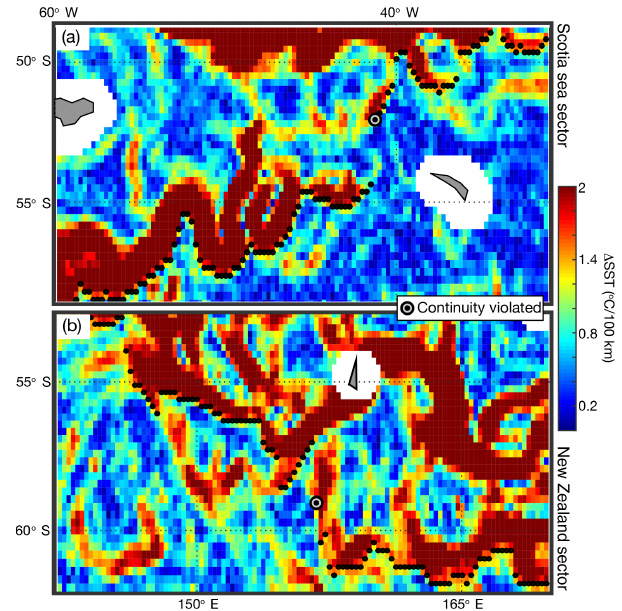
Figure 2. Example cases when spatial and thermal discontinuity is justified: frontal filaments (a) disconnected or (b) situated north- south.